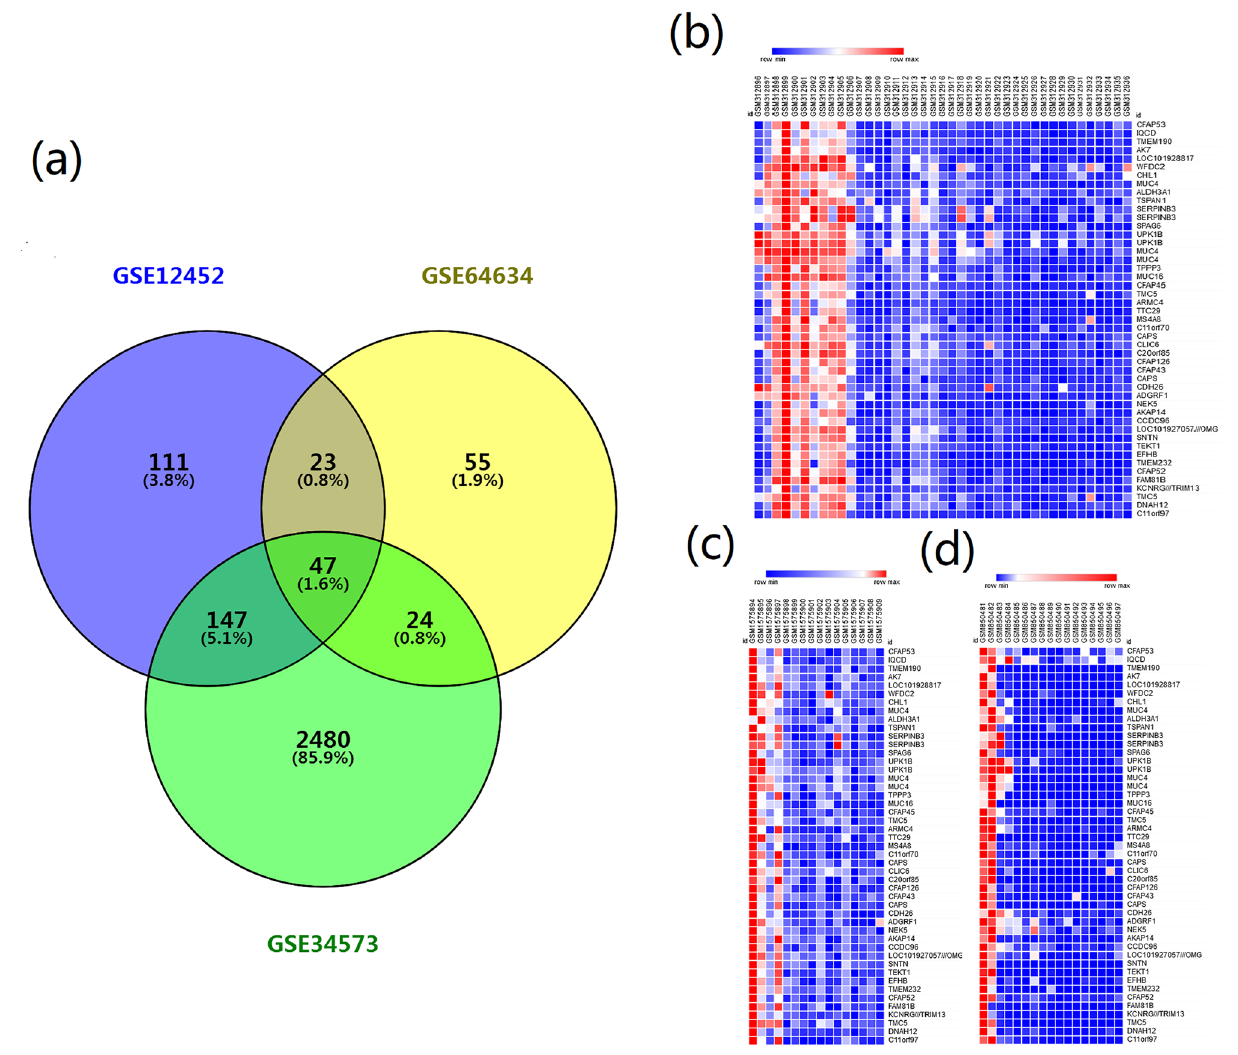
Figure 3. Heat maps and venn diagram of most significant DEGs. ( a ) Venn diagram of DEGs from intersection in 3 GSE datasets. There are 69 intersecting DEGs between GSE12452 and GSE64634, 71 DEGs between GSE64634 and GSE34573, and 194 DEGs between GSE12452 and GSE34573, and 47 DEGs are presented in all GSE datasets. ( b ) Heat map of 47 DEGs in GSE12452, ( c ) GSE64634 and ( c ) GSE34573 datasets. The red marked block indicates the high-level of gene expression and the blue indicated low-level expression. The picture was drawn using R programming language (https:// www.r- proje ct. org/, v4.0.0).